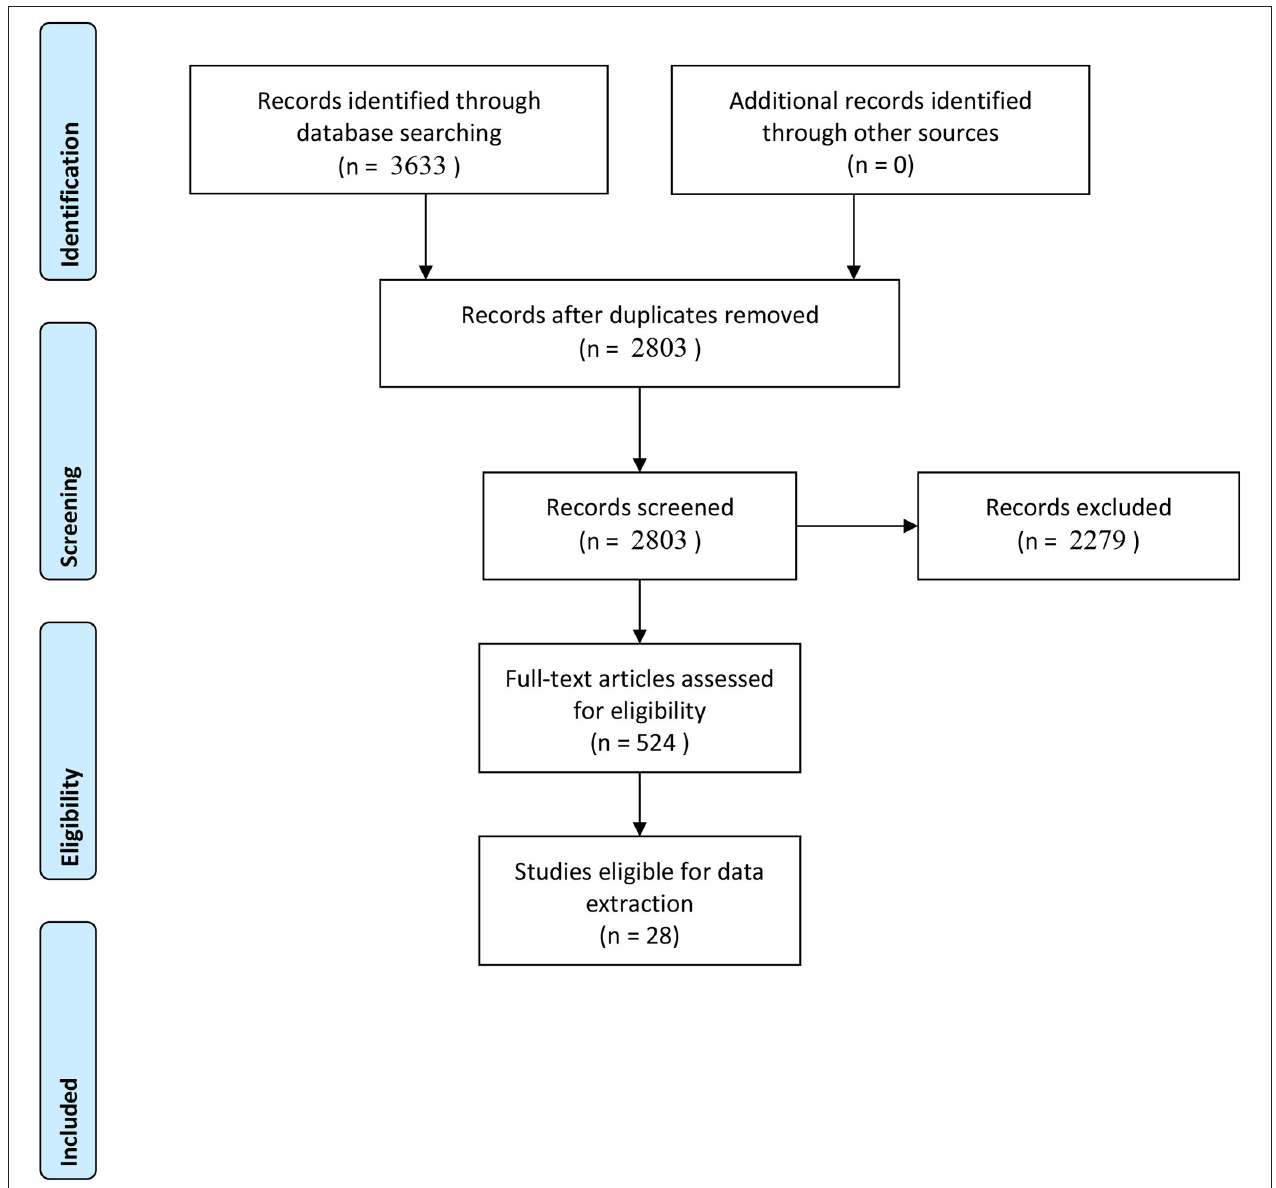
FIGURE 1 | PRISMA 2009 flow